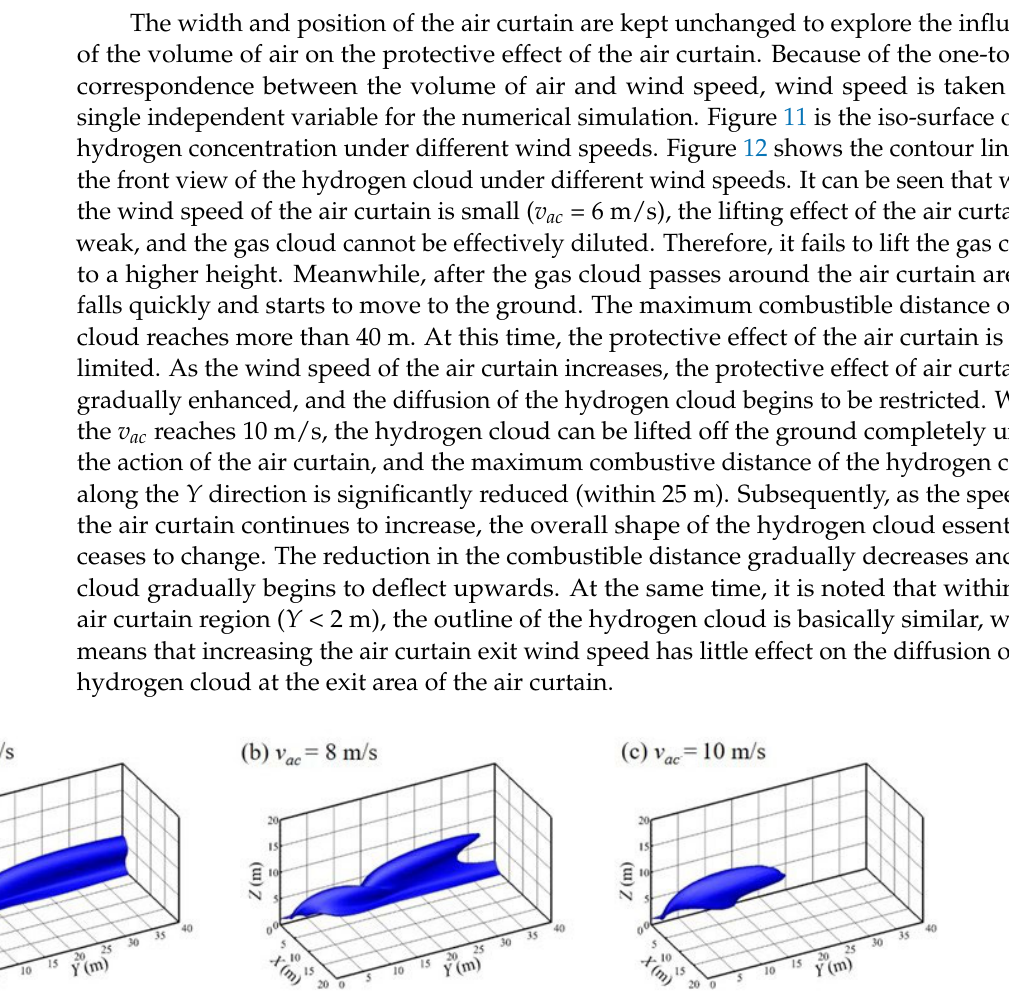
Figure 12. Contours lines in front view with various v ac values ( w ac = 0.25 m, d ac = 2 m, t = 100 s). 2. The influence of different air curtain width s on the protective effect By changing the width of the air curtain ( w ac ), and keeping the position of the air curtain and the volume of air unchanged ( d ac = 2 m, Q ac = 12 m 3 /s), the influence of different